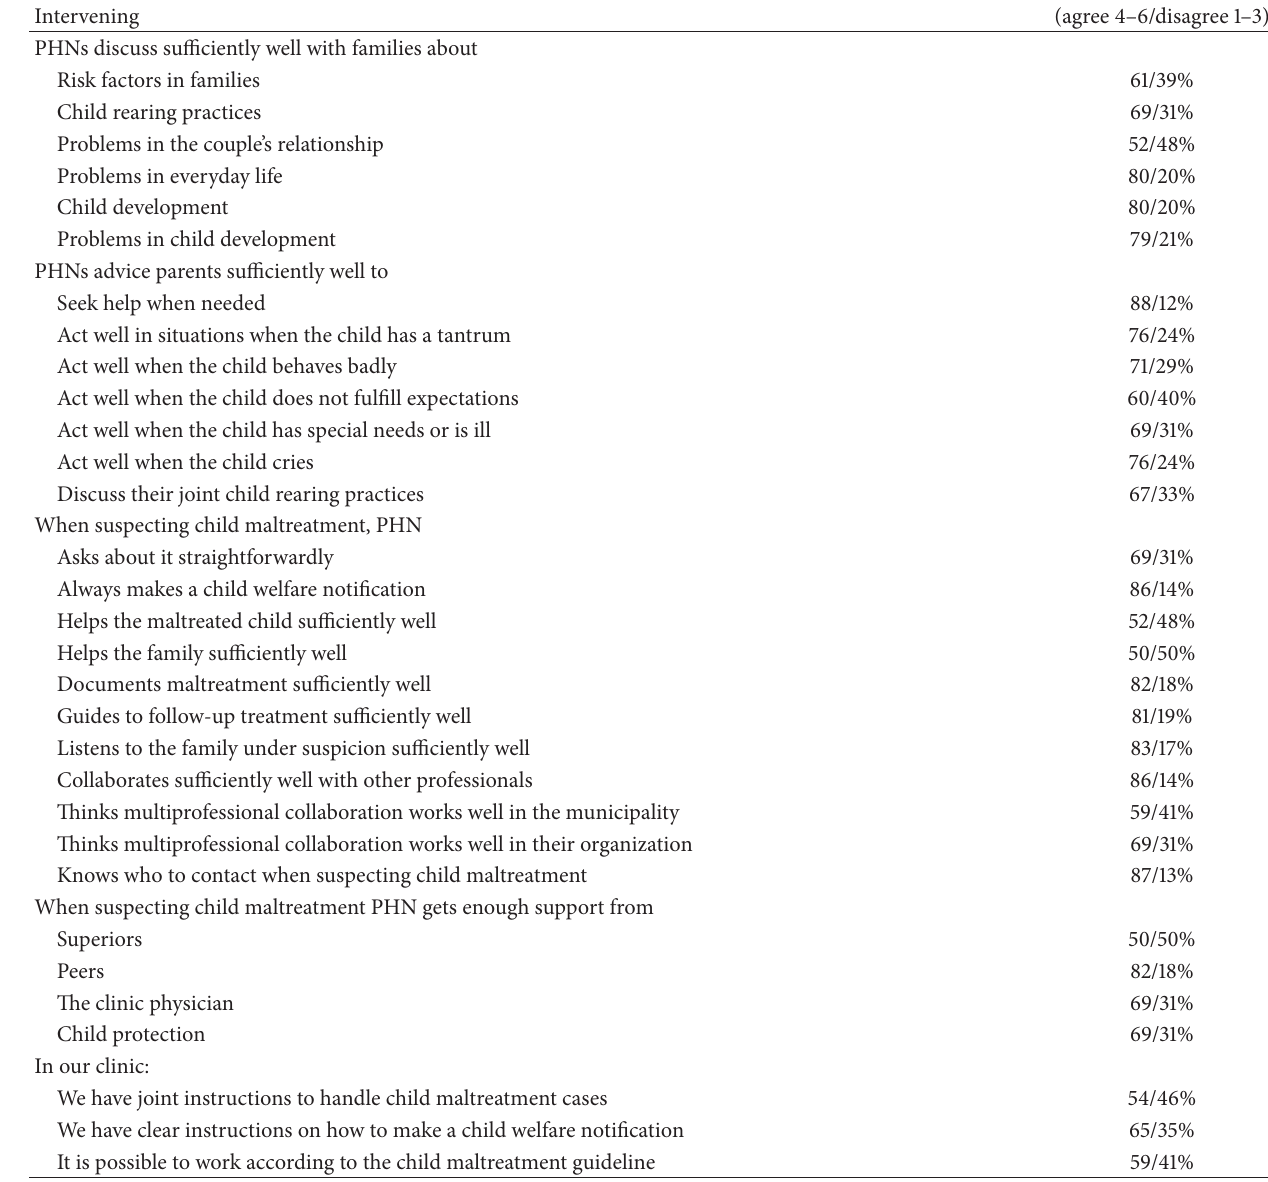
Table 3: Items included in intervening sum variable and the percentages that agree/disagree ( 𝑁 = 367